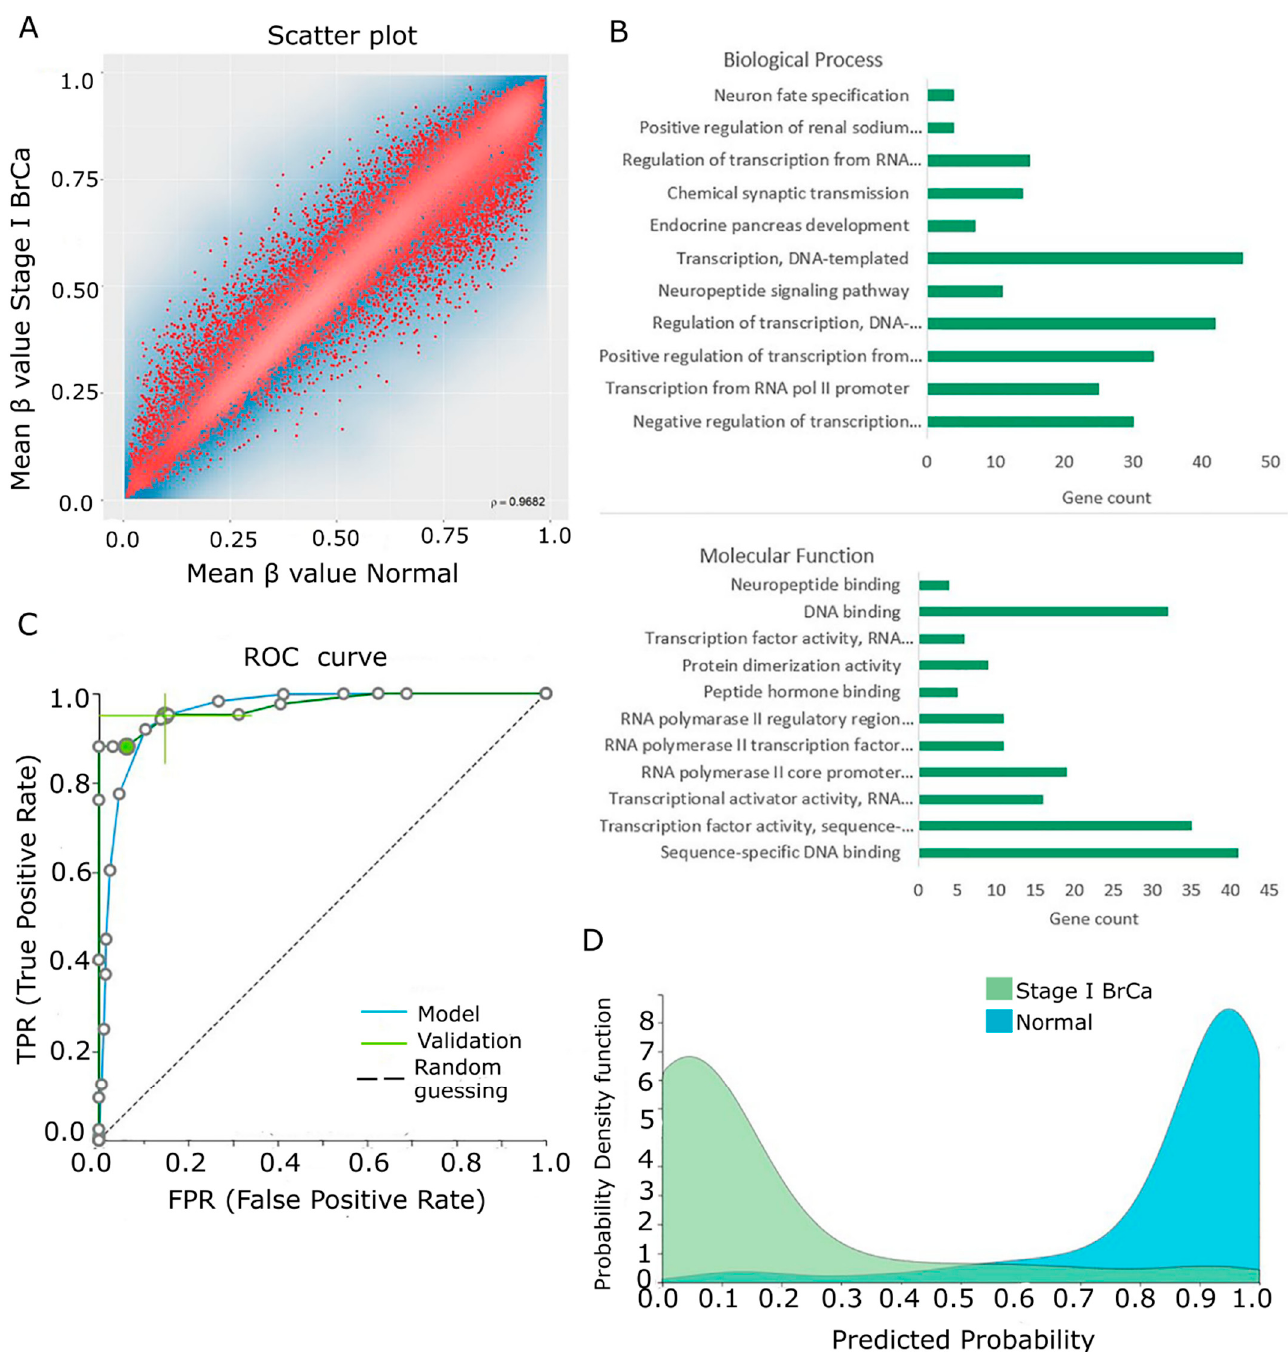
Figure 4. Differential methylation between early-stage BrCa and normal breast tissue. ( A ) Scatterplot showing mean β values for each gene among Stage-I BrCa and normal tissues. ( B ) The gene ontology analysis of the top 250 DMGs in the areas of molecular function, biological process and cellular component analysis. ( C ) ROC curves of training (blue line) and validation (green line) models. ( D ) Probability density plot depicting separated distributions among studied classes of the training group. Abbreviations: BrCa = breast cancer, DMGs = differentially methylated genes, ROC = receiver operating characteristic.